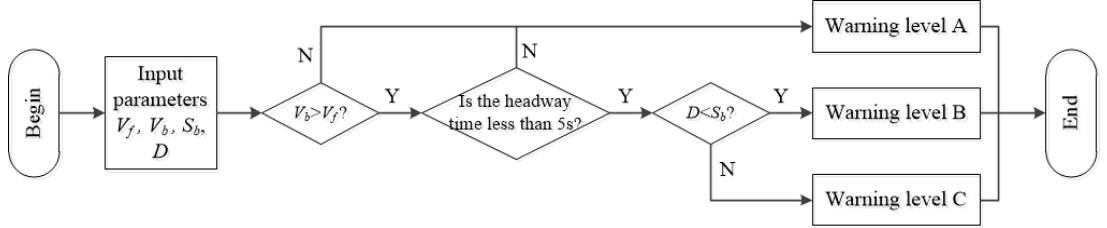
Figure 7. The early warning model.